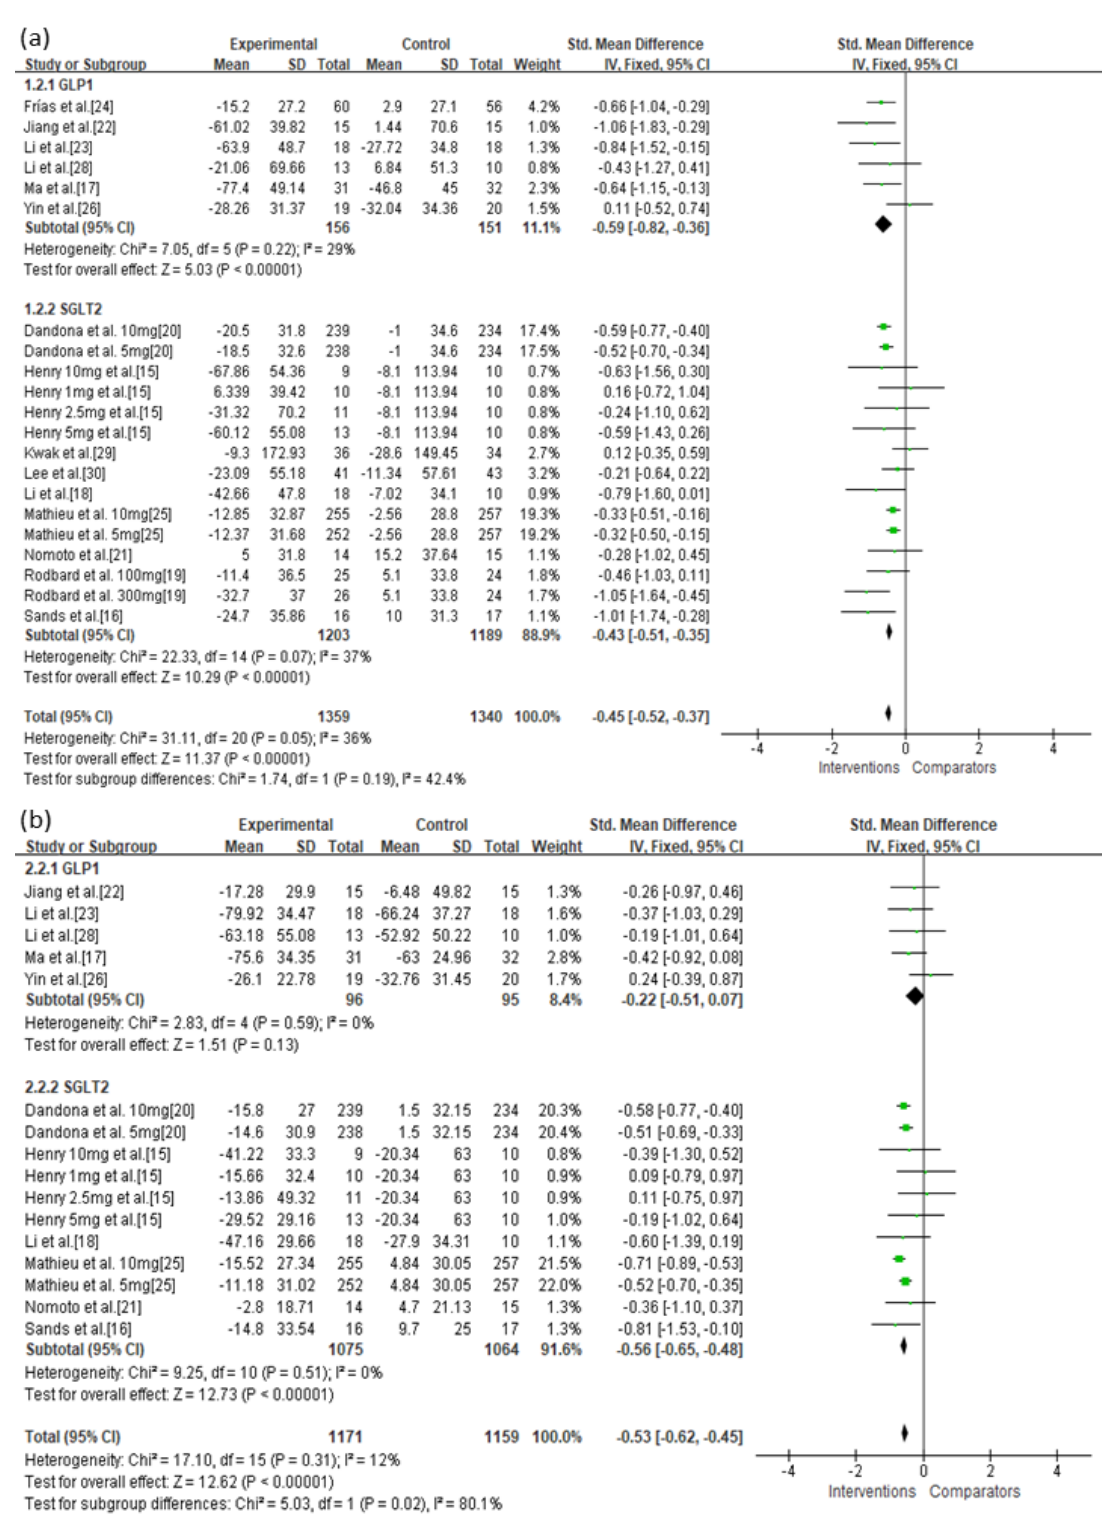
Figure 2. Effects of intervention on MAGE and MBG levels according to SGLT-2 inhibitors or GLP-1 agonists. ( a ) MAGE; ( b ) MBG level. MAGE, mean amplitude of glycemic excursion; MBG, mean blood glucose; GLP-1, glucagon-like peptide 1; SGLT-2, sodium-glucose cotransporter 2. Green squares suggested measure of effect for each of included studies, and black diamond represented as meta-analyzed measure of effect. Bold letters indicated a category or subtotal of each subgroup and overall outcome.